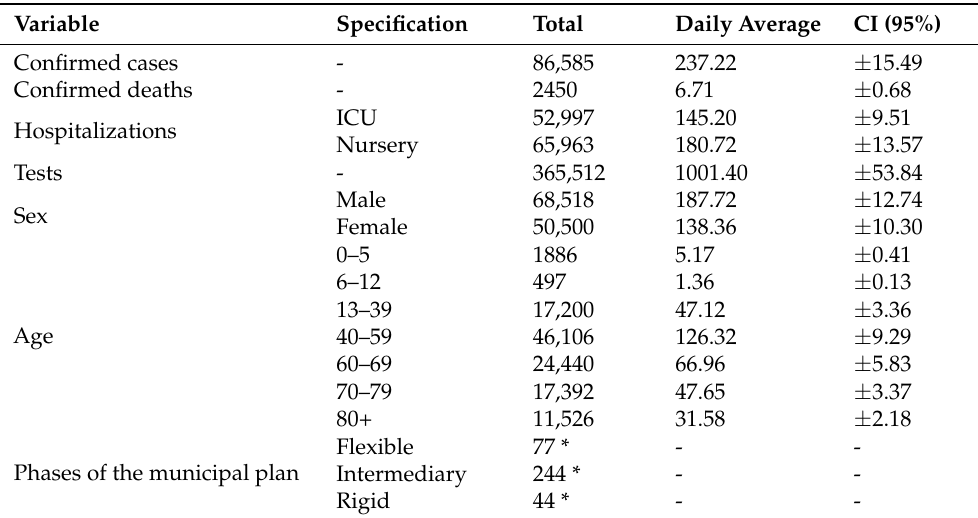
Table 1. Distribution of COVID-19 notifications to the Municipal Health Department of Uberl â ndia (MG), according to the parameters of the present study.